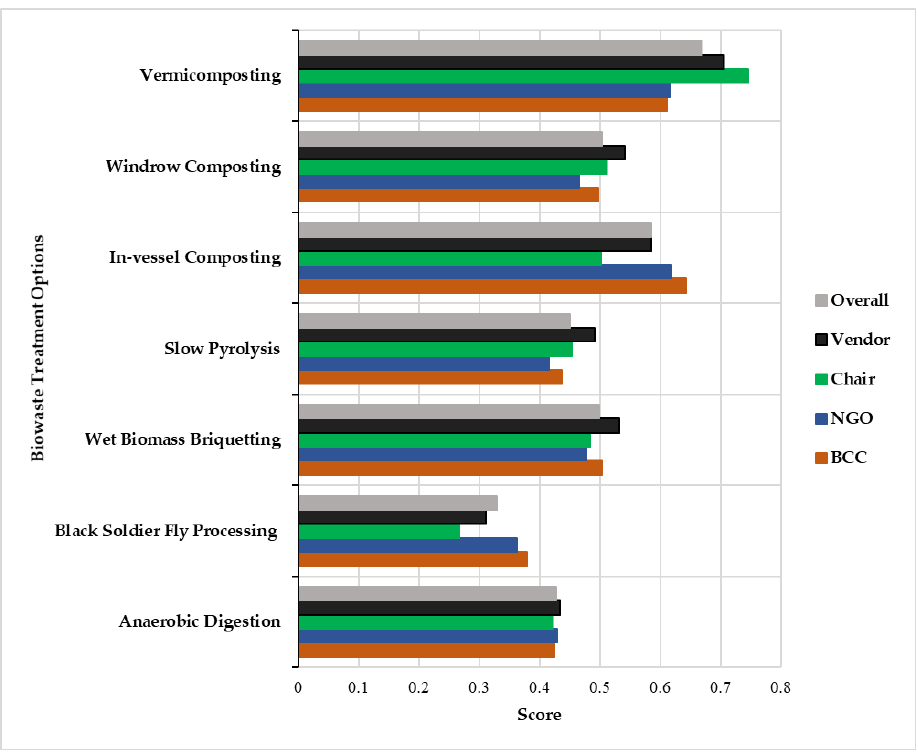
Figure 4. Ranking of the final biowaste technology scores.